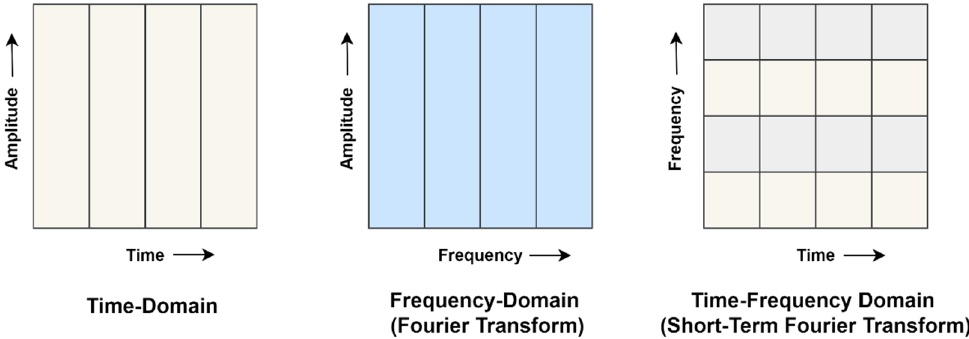
Figure 3. Steps involved in feature extraction in the time domain and frequency domain from raw data.